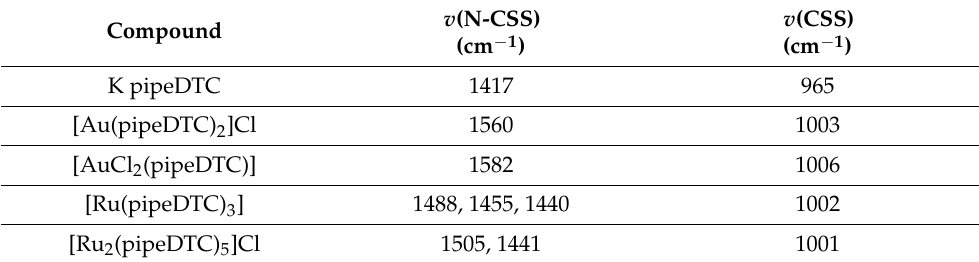
Table 1. List of the main IR vibrations of the metal complexes. Compound